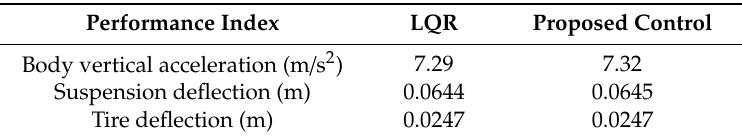
Table 3. Performance index root mean square (RMS) value comparison between the proposed control and the linear quadratic regulator